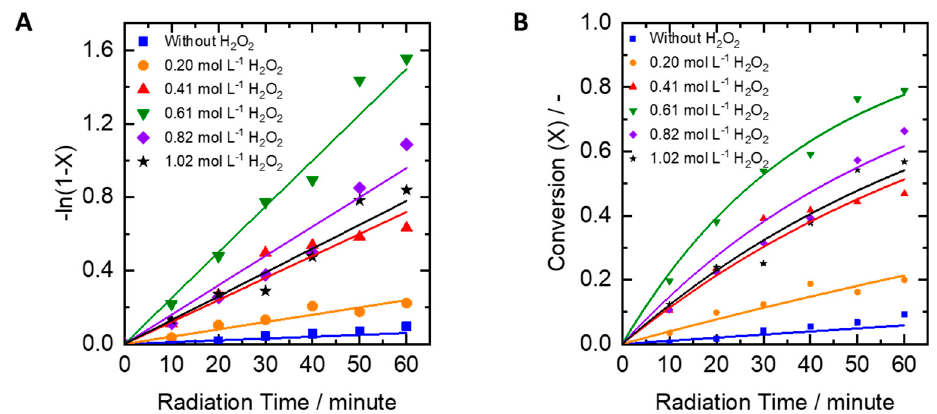
Figure 4. ( A ) Correlation of − ln(1 − x) and reaction time in concentration of hydrogen peroxide variation. ( B ) Data fitted with reaction model in the case of peroxide variation. UV lamp power: 30 watts.